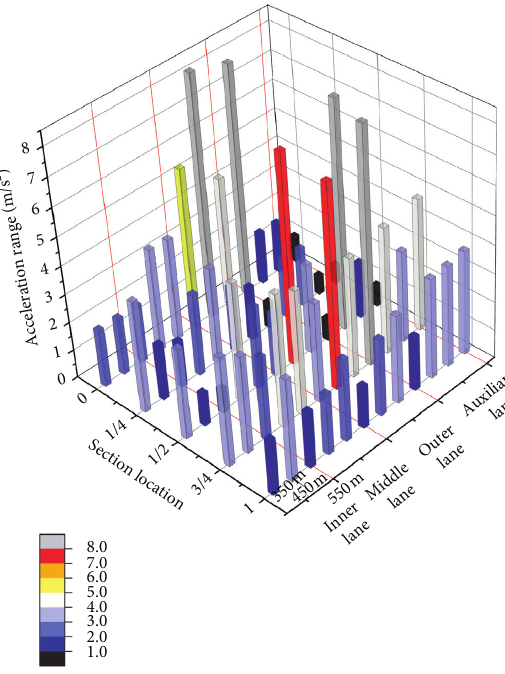
Figure 4: Analysis of acceleration